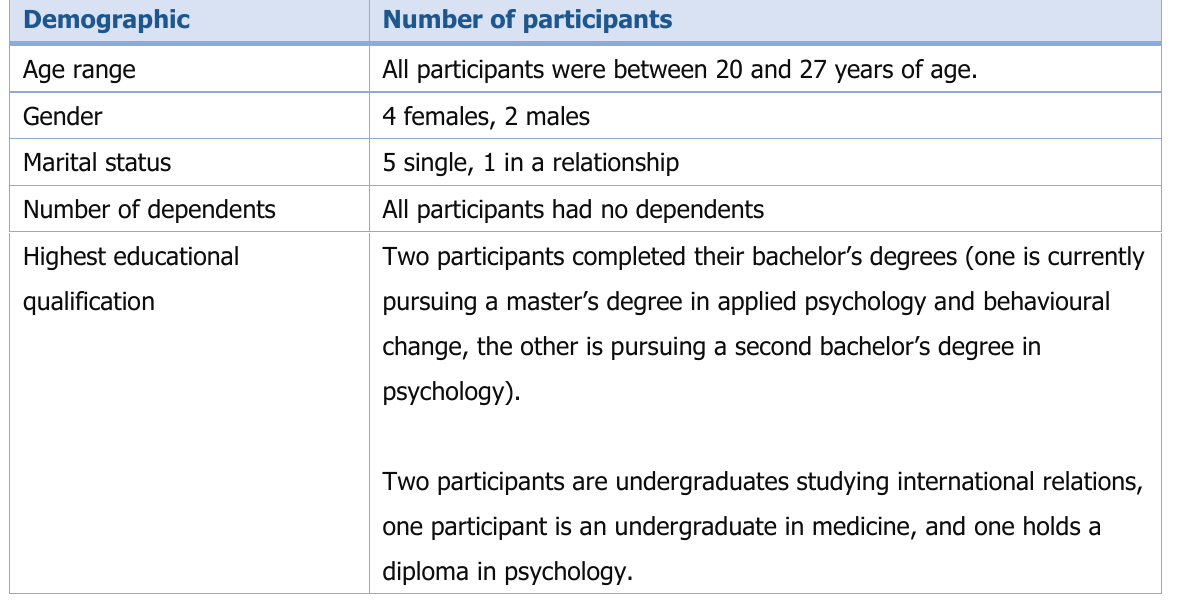
Table 2 . Demographics of the Study Participants